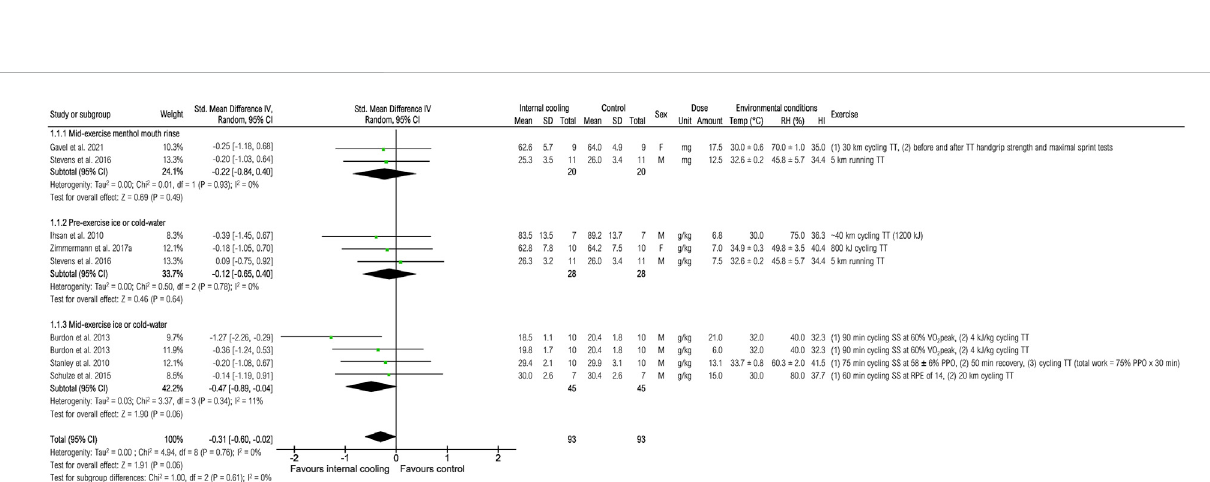
FIGURE 2 Meta-analysis of standardized mean difference in time trial performance [min] with 95% CI between internal cooling and control. F, female; HI, heat index; M, male; PPO, peak power output; RH, relative humidity; RPE, rate of perceived exertion; SS, steady-state exercise; Temp, ambient temperature; TT, time trial; VO 2 peak, peak oxygen